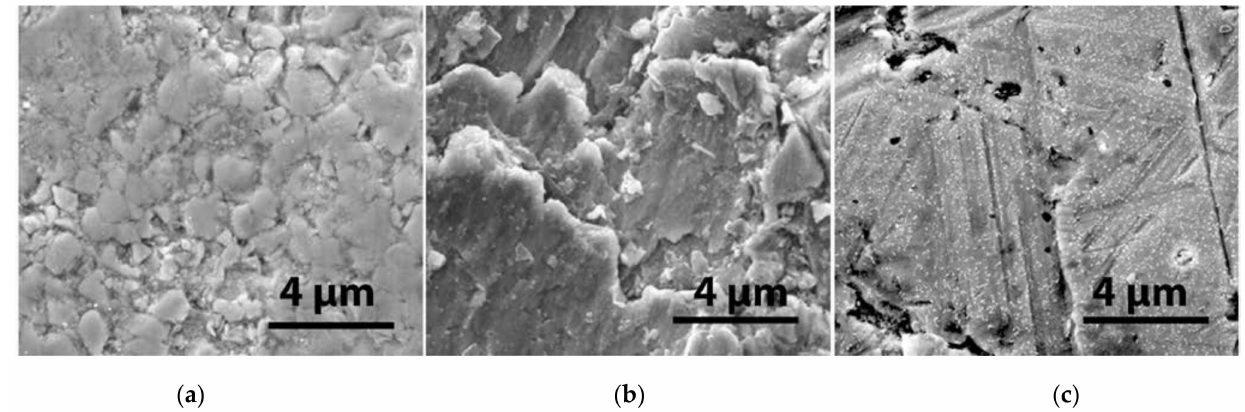
Figure 4. High-magnification images ( × 20,000) of W surface after first session of 10 min irradiation in the 6 MeV EB: ( a ) W-Ti; ( b ) W-Cu and ( c ) W-V.